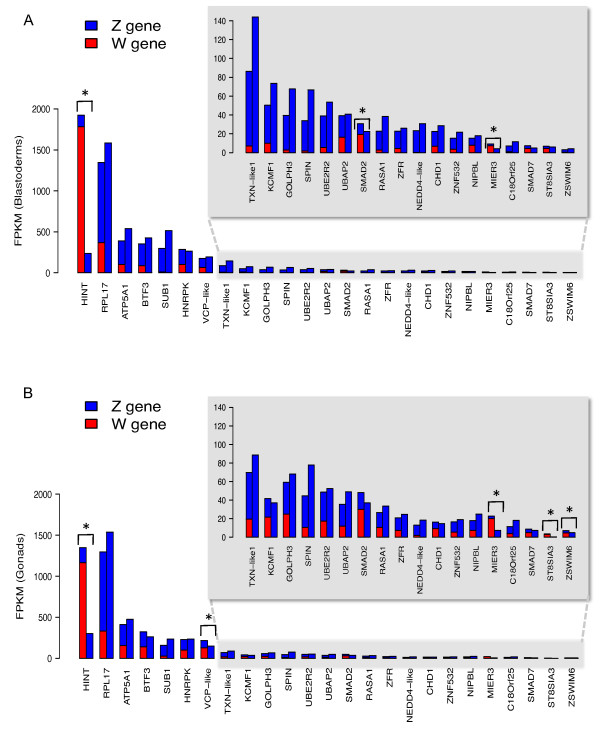
Expression levels of W/Z gametologue pairs. Expression of W-linked genes (red) compared to their Z-linked gametologues (blue), for blastoderms (A) and gonads (B). The total combined expression of gametologue pairs is shown for females (red - W/blue - Z, left bar in pair) and males (ZZ -blue only, right bar in pair). The shaded data are shown on an adjusted FPKM scale (inset). Genes with significantly different expression between the sexes are identified (* P <0.01).